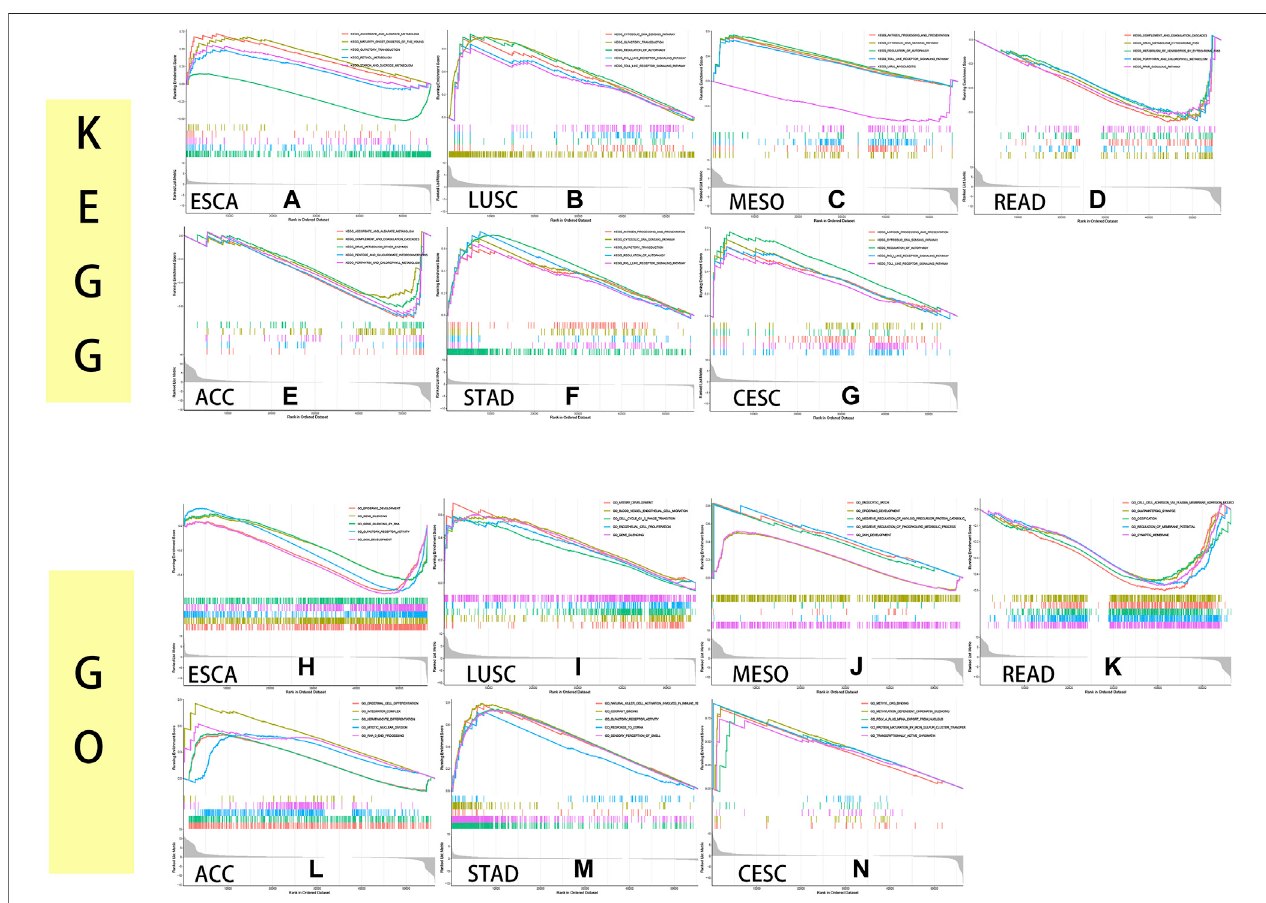
FIGURE 13 | KEGG and GO GSEA of MXD3 in ESCA (A, H) , LUSC (B, I) , MESO (C, J) , READ (D, K) , ACC (E, L) , STAD (F, M) , and CESC (G, N)